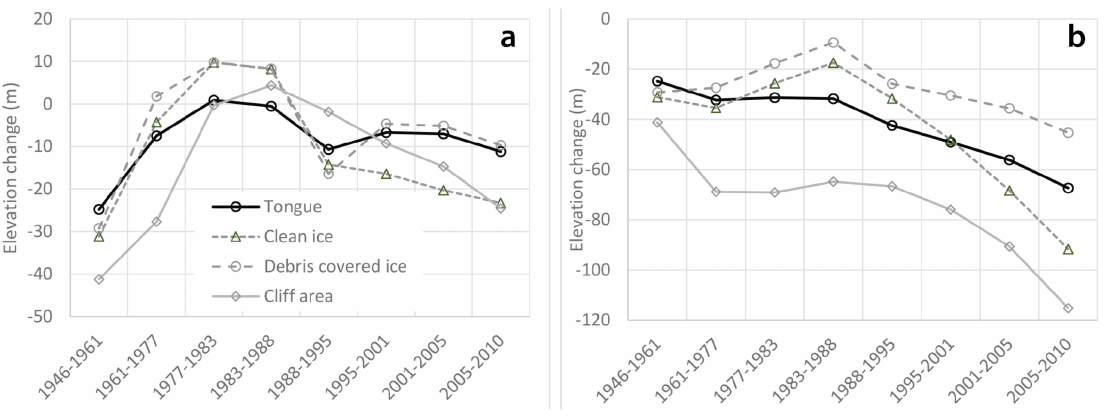
Figure 8. Elevation change for each period ( a ) and cumulative ( b ) over the tongue (black line) and selected areas with different surface cover